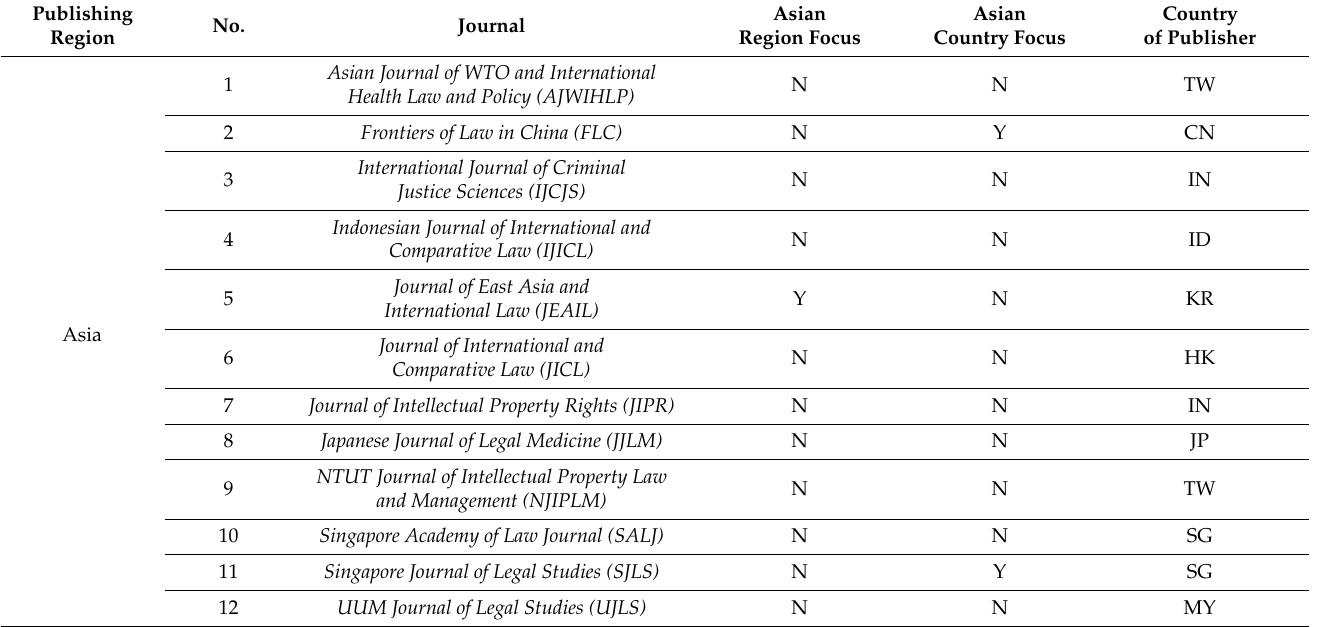
Table 1. Asian Law Journals Published in Asia and Western Countries. Publishing